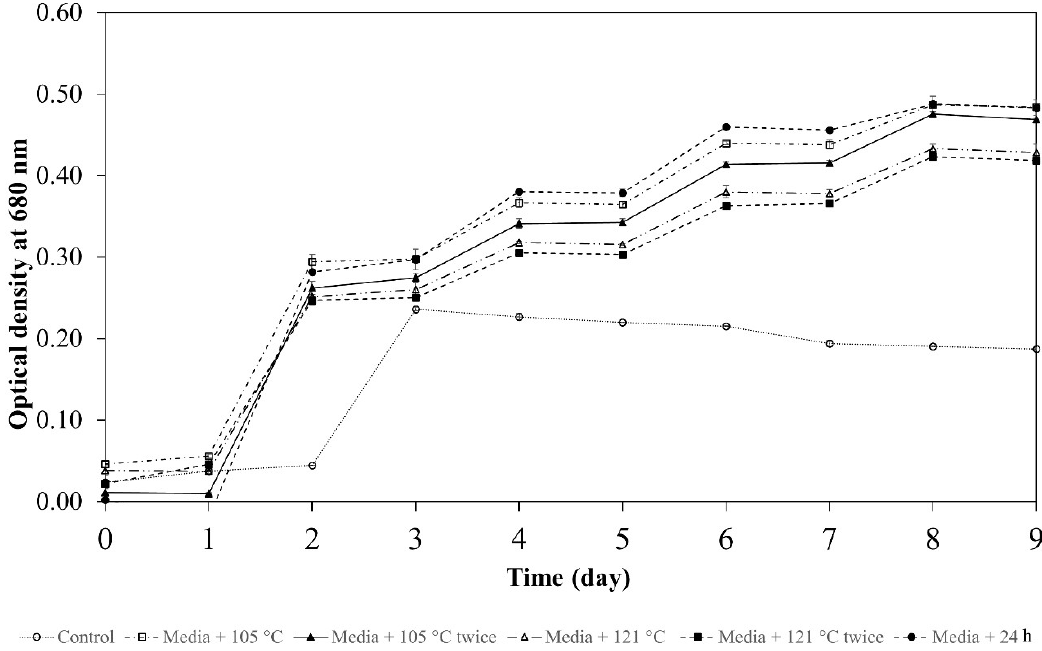
Figure 3. Optical density at 680 nm of Nannochloropsis oculata . Error bars represent the standard deviation between three replicates ( n = 3).